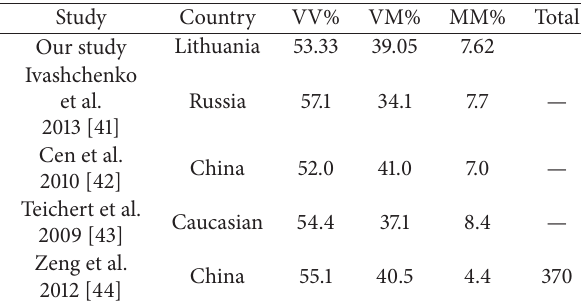
Table 11: Frequency of CYP4F2 rs2108622 genotypes in the control groups from other